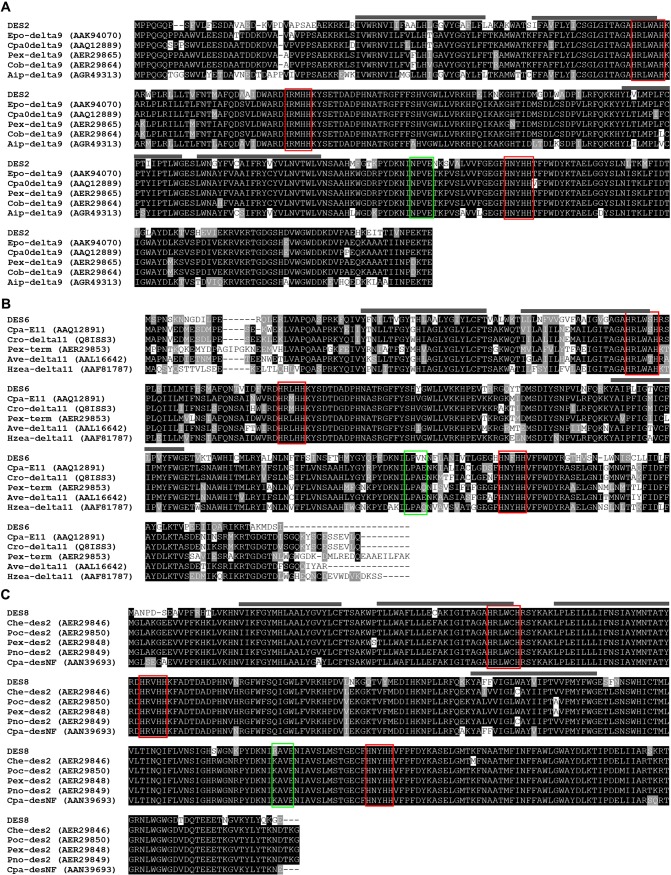
Sequence alignments of DES2, DES6 and DES8 with other desaturases from Lepidoptera.Epo: Epiphyas postvittana, Cpa: Choristoneura parallela, Pex: Planotortrix excessana, Cob: Ctenopseustis obliquana, Aip: Agrotis ipsilon, Cro: Choristoneura rosaceana, Ave: Argyrotaenia velutinana, Hzea: Helicoverpa zea, Poc: Planotortrix octo, Pno: Planotortrix notophaea. The protein ID is shown in parenthesis. The red box indicates the histidine rich motif. Gray bars above the sequence indicates transmembrane domains. The green box indicates the signature motif as described in Knipple et al. [17].